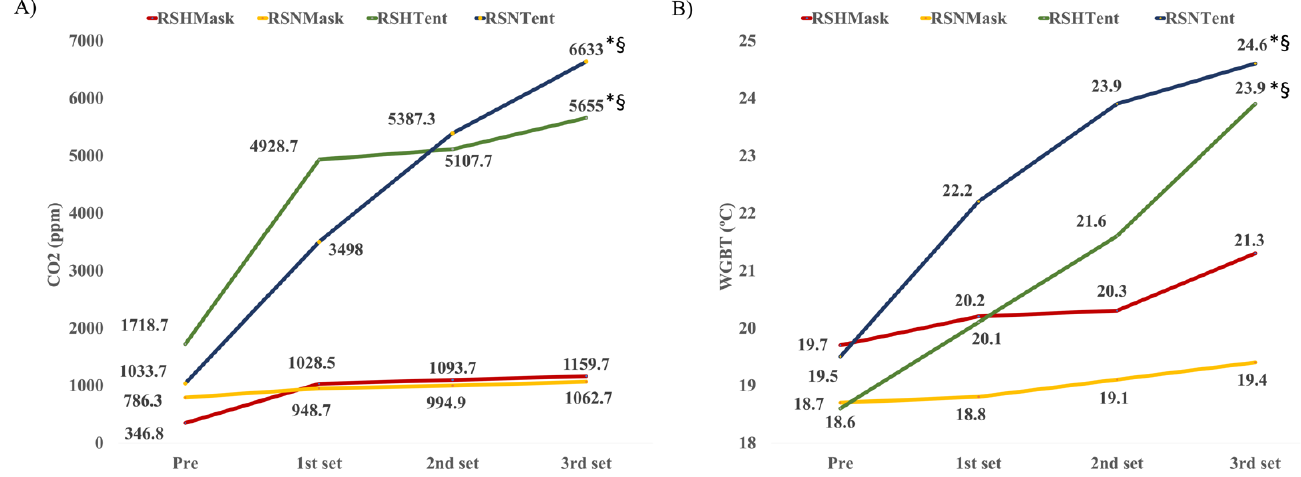
Figure 3. Changes in environmental conditions (A) : CO 2 and (B) : WGBT); by time and conditions during a repeated-sprint workout in normoxia and hypoxia. Statistical difference between § RSN Mask and * RSH Mask . RSHTent = repeated-sprint in normobaric hypoxia using a tent, RSHMask = repeated-sprint in normobaric hypoxia using a mask, RSNTent = repeated- sprint in normoxia using a tent, RSNMask = repeated-sprint in normoxia using a mask.